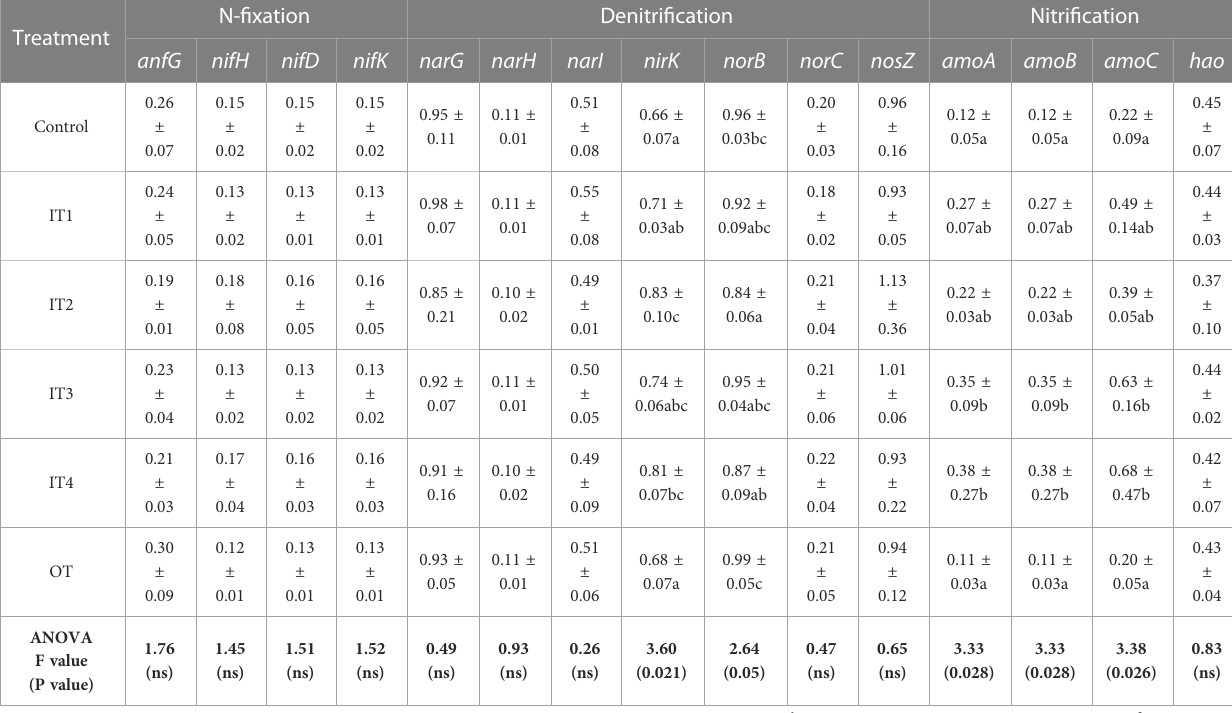
TABLE 2 Predicted N metabolism pathway genes count detected under the fi ve different fertilization treatments.